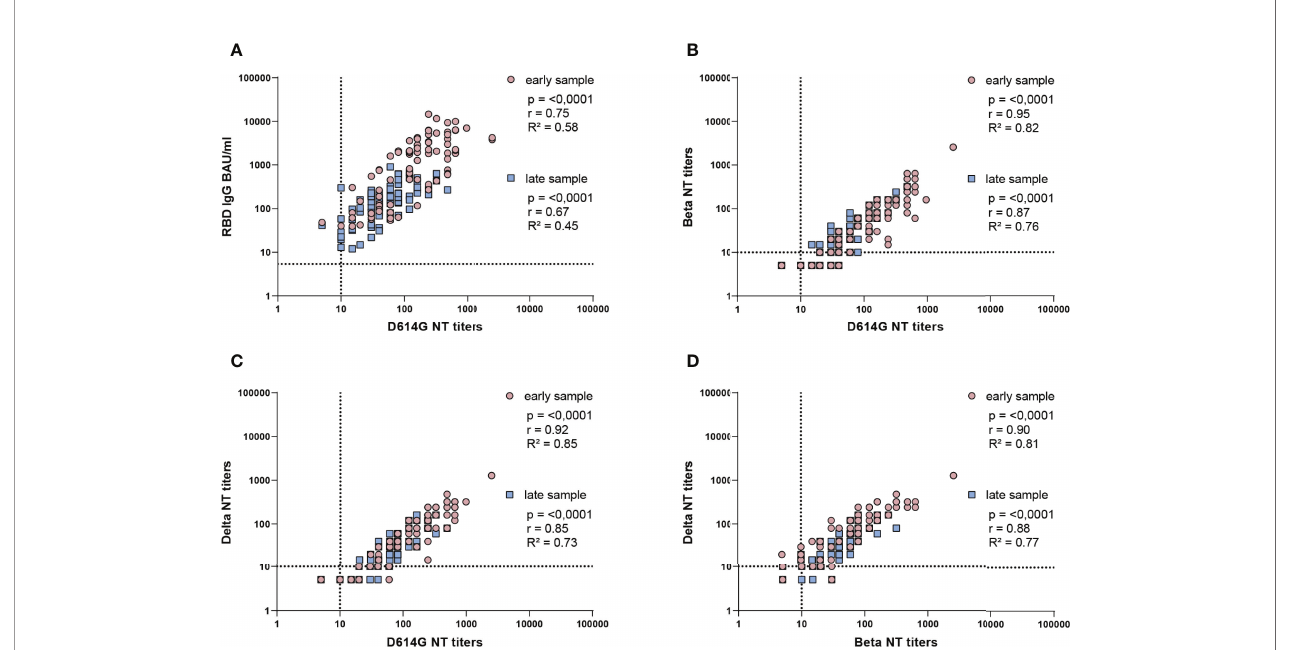
FIGURE 4 | Correlation analysis of ELISA concentrations and NT titers of all samples. Spearman correlation coef fi cients (r) and coef fi cients of determination (R 2 ) are indicated. (A) IgG in BAU/ml and D614G virus NT titers, (B) D614G virus and Beta VOC NT titers, (C) D614G virus and Delta VOC NT titers, (D) Beta VOC and Delta VOC NT titers. All samples from infected and vaccinated individuals for which early and late samples were available are included. Early samples were taken approximately three weeks after disease onset or the second vaccine dose; late samples approximately six months after disease onset or the second vaccine dose. The dotted lines indicate the cut-offs of the speci fi c